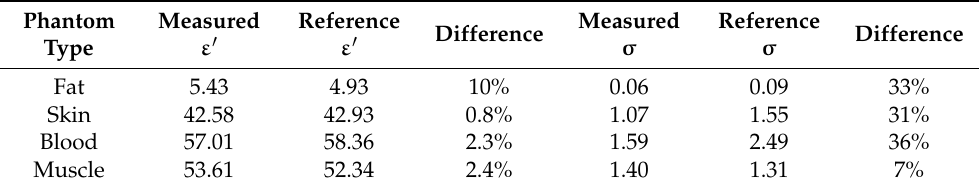
Table 3. Measured and reference dielectric parameters at 2.4